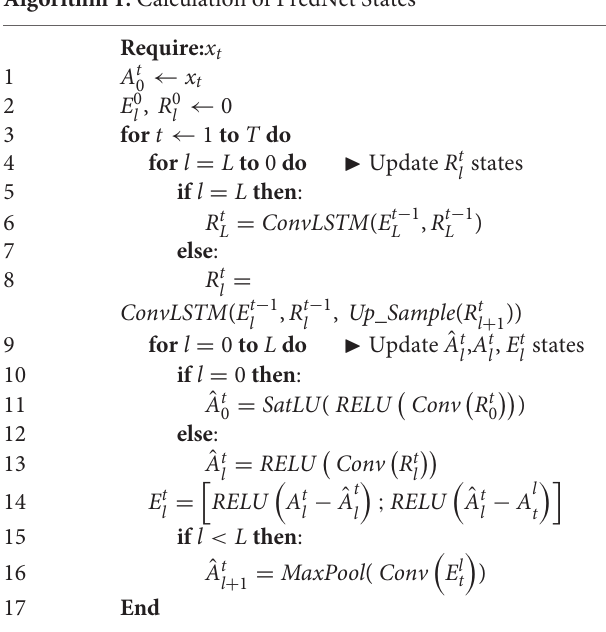
Algorithm 1 was proposed by Lotter et al. (2017). The R t